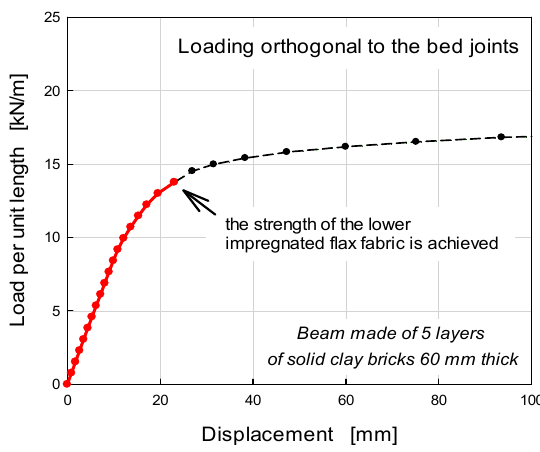
Figure 5. FEM: load-displacement curve for masonry beam reinforced by flax fiber under vertical loads.